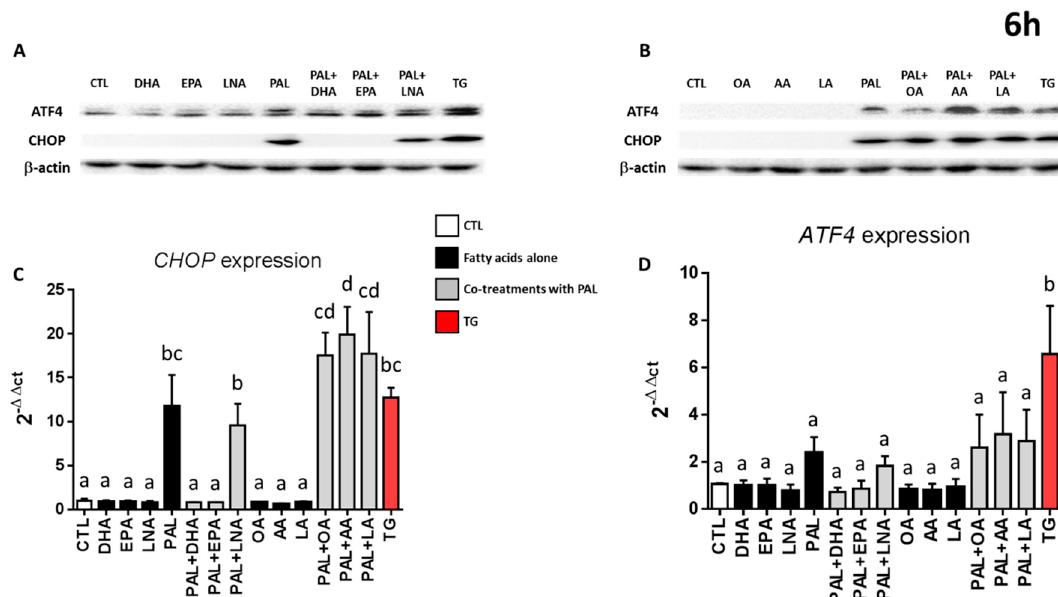
Figure 4. Only EPA and DHA prevent endoplasmic reticulum stress induced by palmitic acid. LS174T cells were treated for 6 h with control BSA, 300 µM PAL, or 200 nM thapsigargin alone, or with 25 µM DHA (docosahexaenoic acid), EPA (eicosapentaenoic acid), LNA (linolenic acid), OA (oleic acid), AA (arachidonic acid), or LA (linoleic acid) alone or in co-treatment with 300 µM PAL. After 6 h of treatment, cell lysates were immunoblotted for ATF4, CHOP, and actin. Representative western blots are presented in ( A ) and ( B ). The impact of 6 h of treatment with the different fatty acids and the ER stress inducer thapsigargin on the mRNA expressions of CHOP and ATF4 were analyzed by quantitative RT-PCR. Results are expressed relatively to CTL and normalized to β -actin ( C ) and ( D ). Data are expressed as the mean ± SEM of three independent experiments. Differences were analyzed by Tukey’s multiple comparison test. Bars assigned different superscript letters (a, b, c) were statistically different at p < 0.05. CTL: control bovine serum albumin (BSA); TG, thapsigargin; ATF4: activating transcription factor 4; CHOP: CCAAT-enhancer-binding protein homologous protein; ER: endoplasmic reticulum.